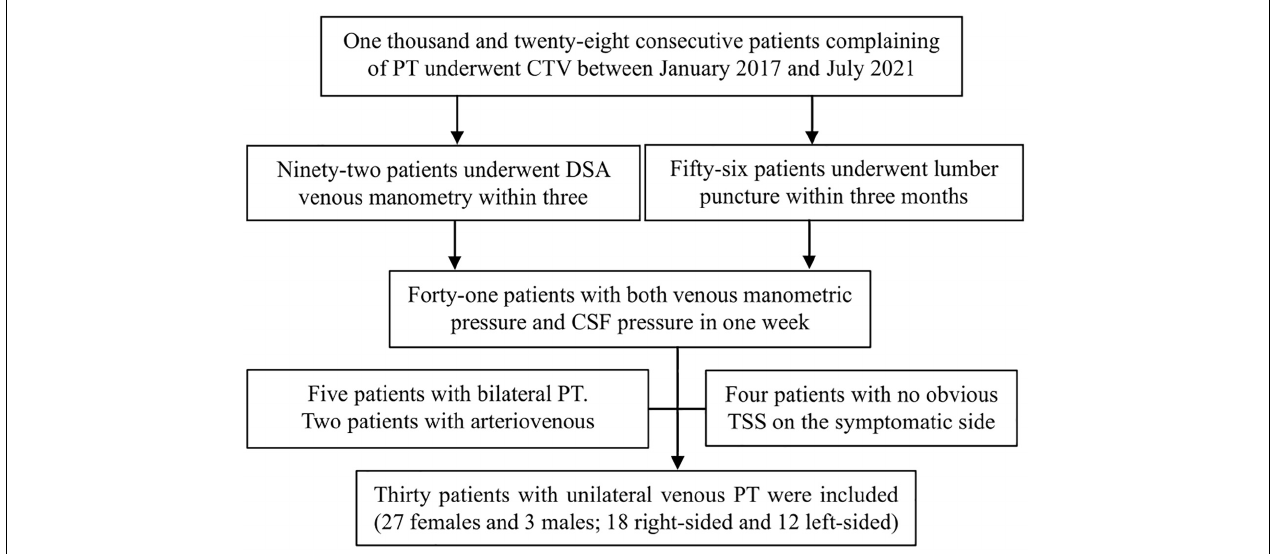
FIGURE 1 | The inclusion process applied in this study. PT, pulsatile tinnitus; CTV, computed tomography venography; DSA, digital subtraction angiography; CSF, cerebrospinal fluid; TSS, transverse sinus stenosis.